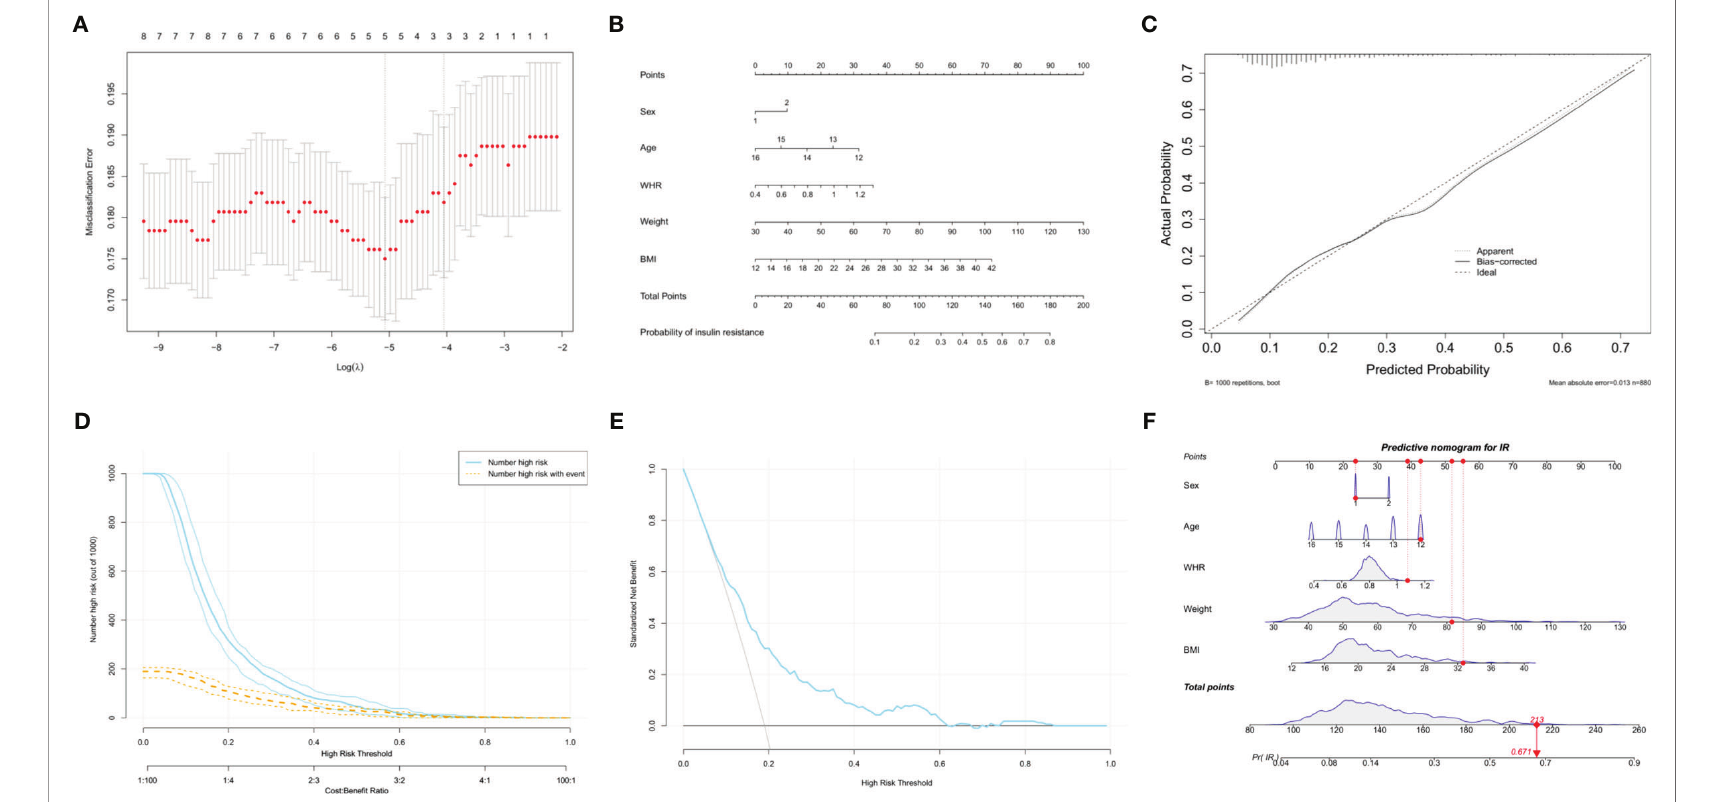
FIGURE 3 | Development of an anthropometry-based nomogram for predicting insulin resistance among adolescents in China. (A) The LASSO coef fi cient pro fi les of eight variables. The coef fi cient pro fi le plot was produced against the log(lambda) sequence. Five features with nonzero coef fi cients were selected by optimal lambda (0.006259), including sex, age, waist-to-hip ratio (WHR), weight and body mass index (BMI). (B) An anthropometry-based nomogram for the prediction of insulin resistance (IR) among adolescents in China, that includes sex, age, WHR, weight and BMI. (C) The calibration analysis. The x- and y-axes represents the nomogram-predicted probability of IR and the actual rate of IR, respectively. The solid line represents the performance of the nomogram. A more favorable performance is indicated by a closer fi t to the ideal calibration line (the diagonal dotted line). (D) The clinical impact curve for evaluating clinical use. (E) The decision curve for evaluating clinical use. (F) Dynamic nomogram. An adolescent was randomly selected from the population, and the risk of IR was predicted using the fi ve anthropometric indices of the